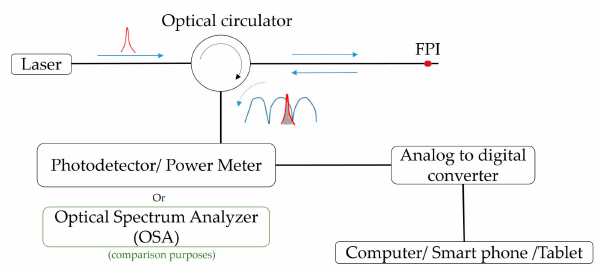
Figure 2. Proposed FPI interrogation architecture for high rate dynamic applications.